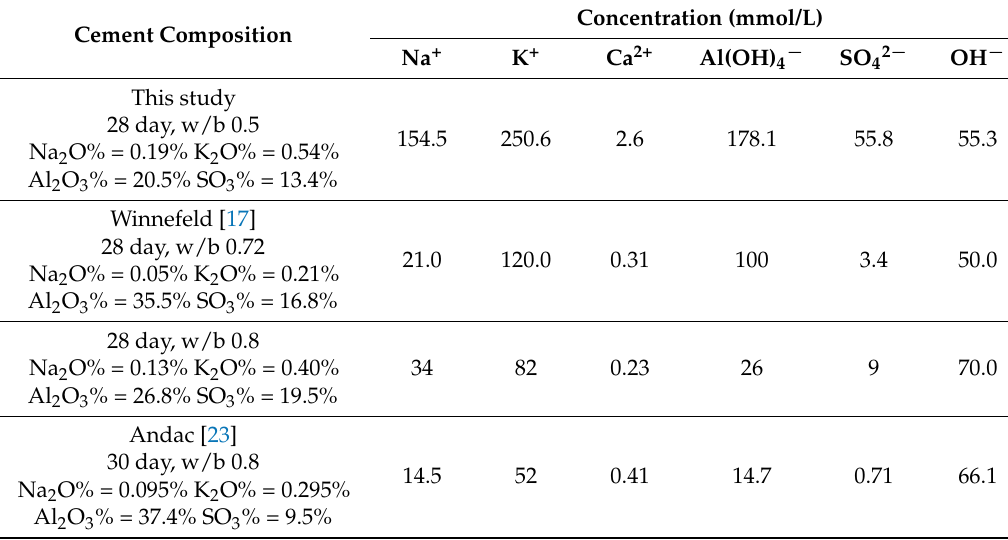
Table 8. Summary of chemical analysis of pore solutions